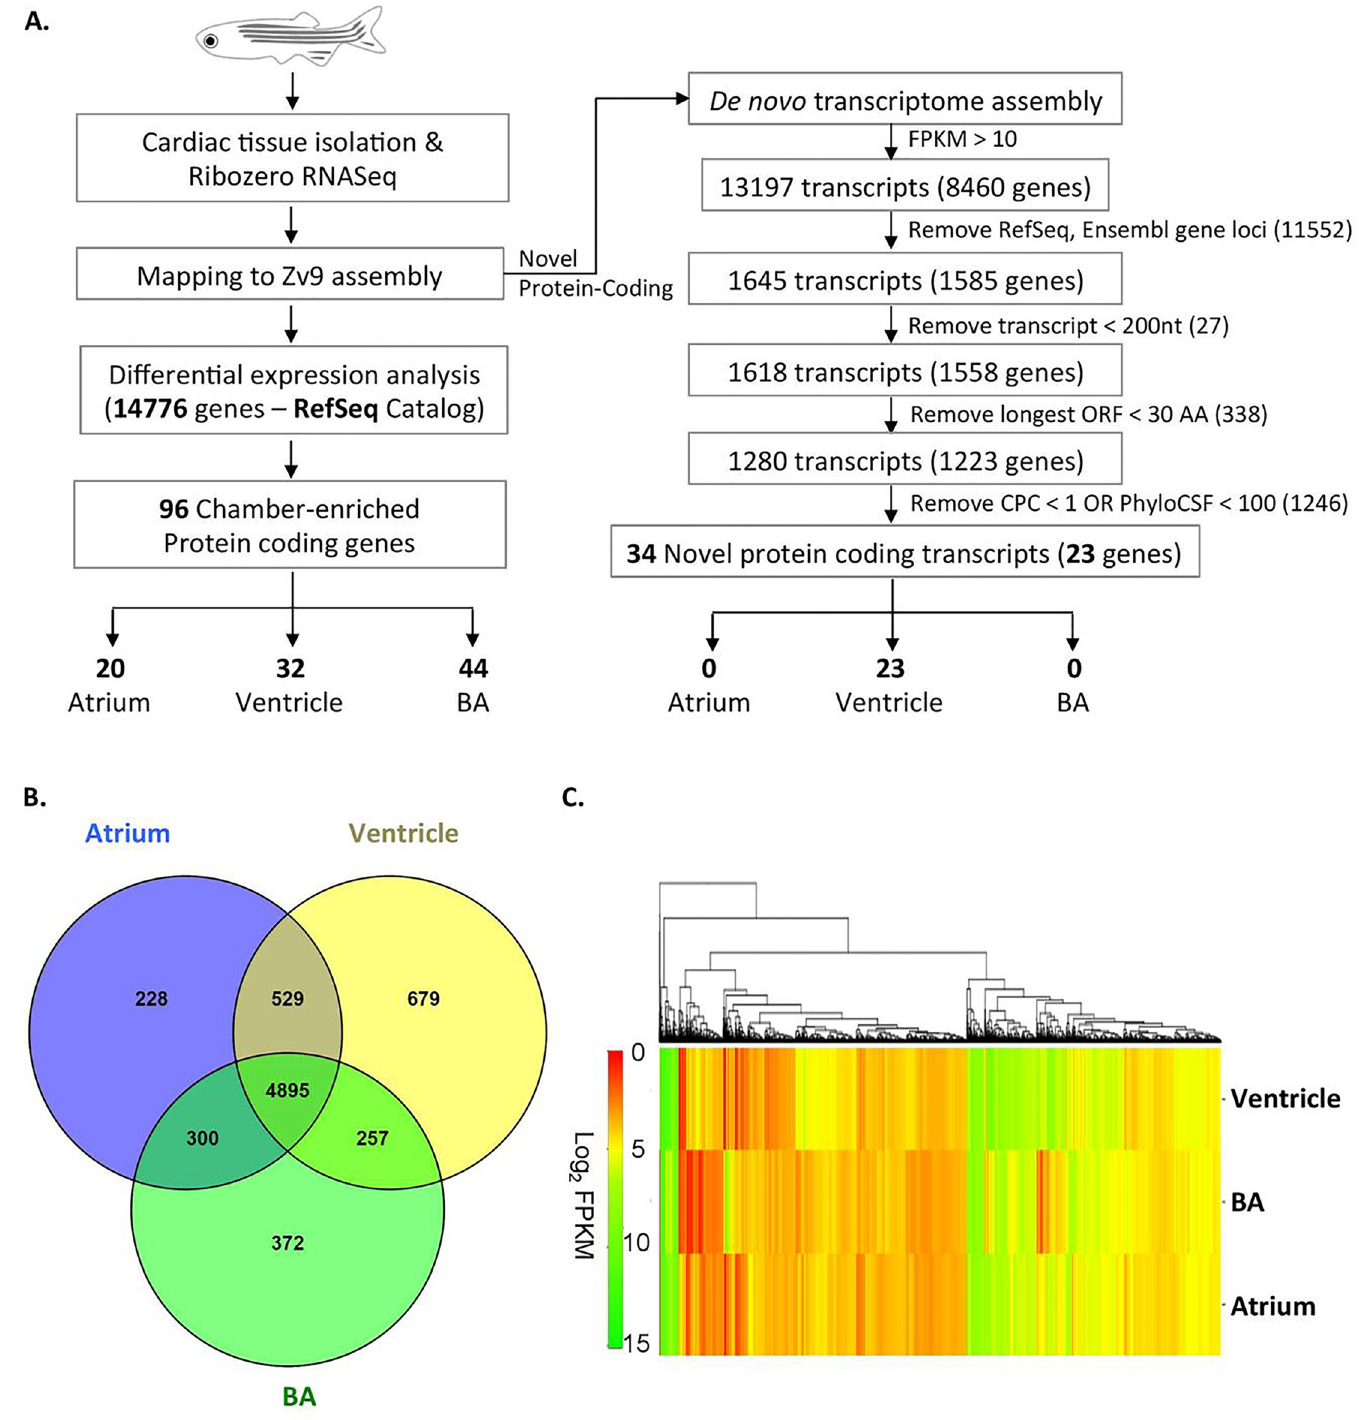
Fig 1. Data workflow and analysis summary. An overview of experimental and data analysis workflow adopted in the study for identification of known and putative novel cardiac chamber-restricted protein coding genes. (B) Venn diagram representing the total number of known protein coding genes (7,260) identified with expression level > = 10 FPKM across the three cardiac chambers. (C) A heat map representing expression pattern of 7,260 RefSeq protein coding genes with expression level > = 10 FPKM in the three cardiac chambers. The colour key represents transcripts in the range of 0 for transcripts with least expression to 15 for transcripts with maximum